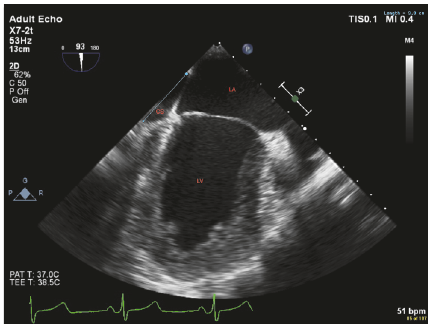
Figure 3: Midesophageal 2-chamber view showing dilated coronary sinus (3.3 cm). LA = left atrium, LV = left ventricle, and CS = coro- nary